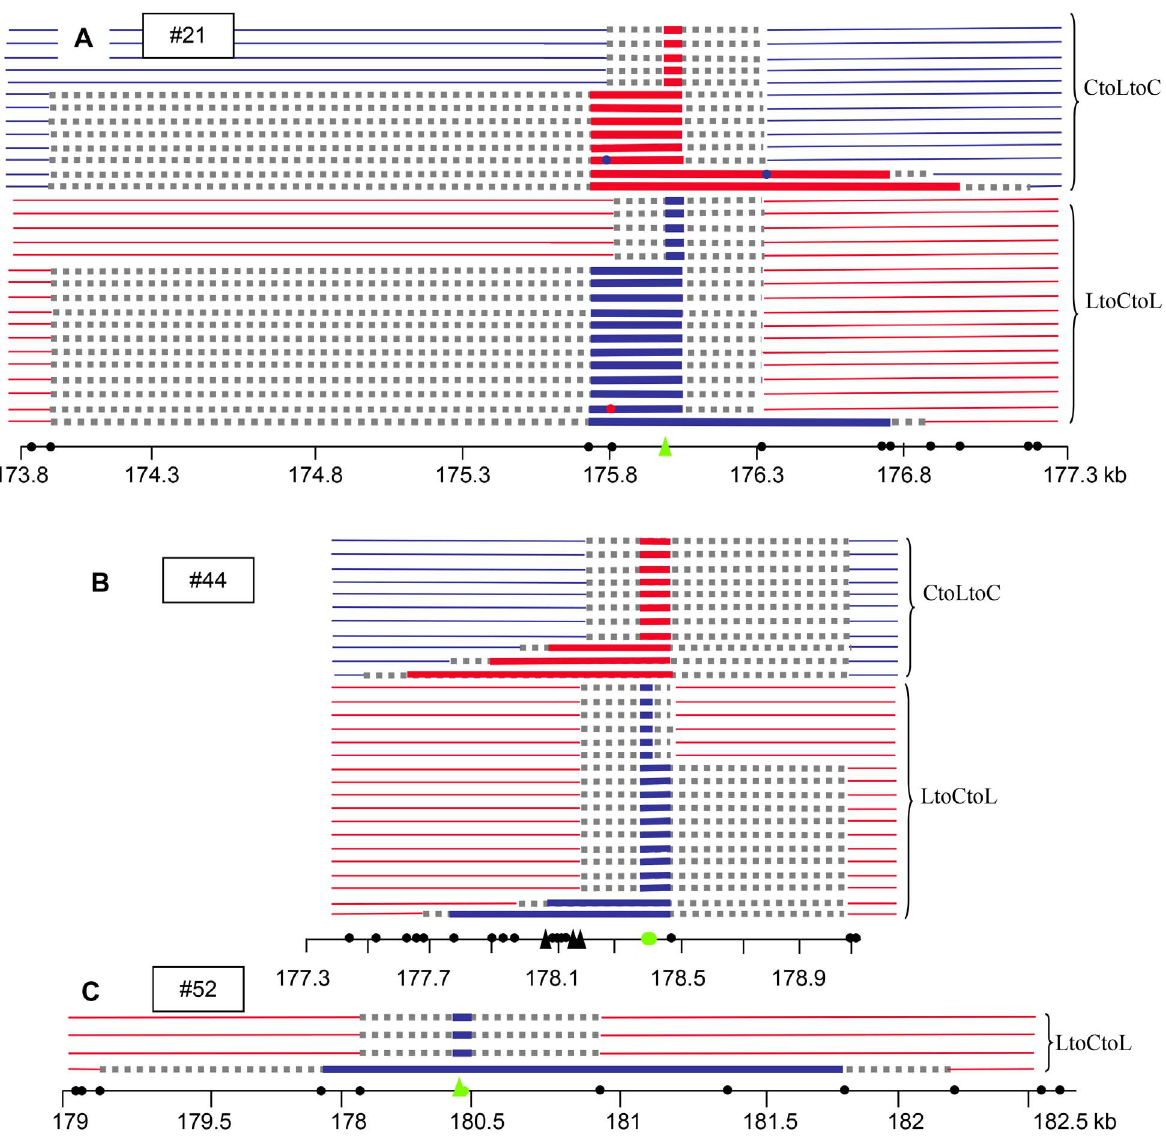
Figure 6. NCO events at 130 6 . (A) SNP # 44, (B) SNP # 21, (C) SNP # 52. The positions of the SNPs genotyped are indicated by green filled circles (SNPs) or triangles (indels). The polymorphisms are indicated by filled black circles along the chromosome coordinate axes. Triangles: insertion or deletion greater than 7 bp. Thick red or blue horizontal lines: converted SNPs, Thick grey dotted horizontal lines: interval in which NCO tract ends are located. Blue: Col; Red: L er